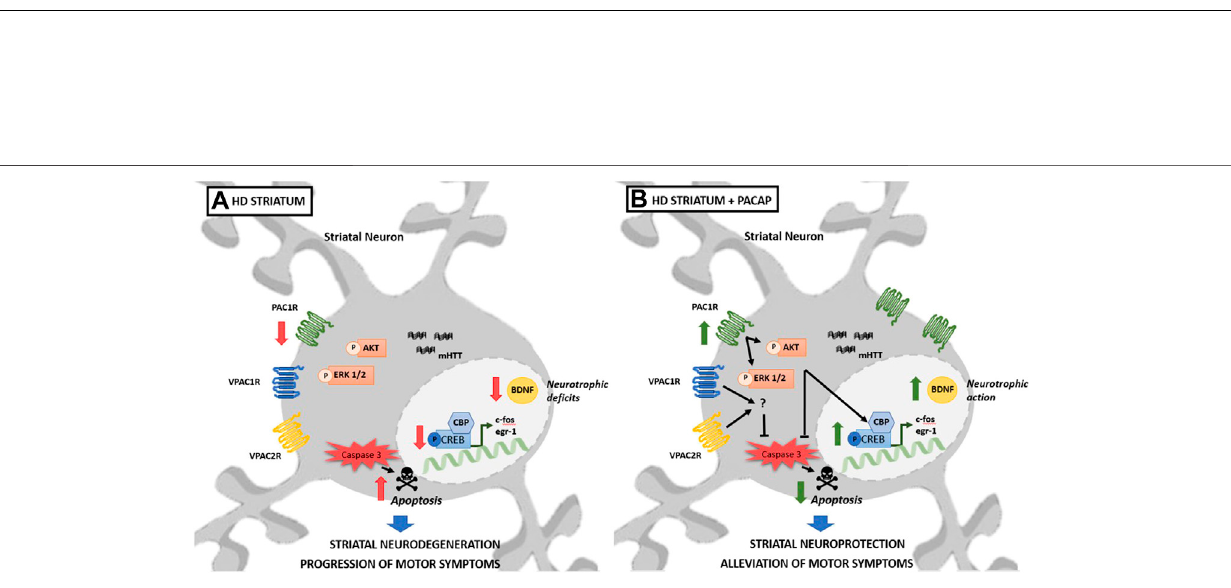
Frontiers in Pharmacology |